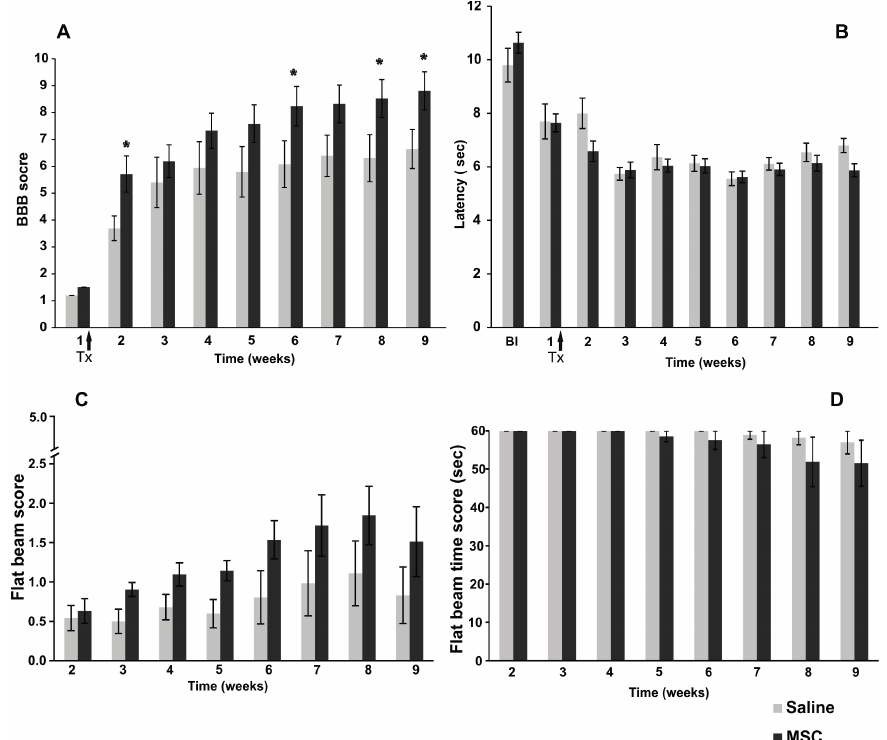
Figure 2. Functional recovery after spinal cord injury: ( A ) Improvement in locomotor behavior on the Basso, Beattie, and Bresnahan (BBB) scale after spinal cord injury (SCI) in control and MSC-treated groups. The MSC-transplanted rats demonstrated superior BBB scores with significant improvement, when compared to controls; ( B ) The plantar test was used to measure the effect of MSC implantation on thermal stimulation. No significant effect of implanted MSC on hyperalgesia was observed during the study; ( C ) The flat beam test evaluates the muscle strength, body and forelimb-hindlimb coordination in MSC and control groups. MSC-treated animals showed an insignificant strong trend improvement compared to the control group from the sixth week onwards after SCI; ( D ) The flat beam time score shows the ability of treated animals to move across the beam within 60 s, which was observed from the fifth week onwards in the MSC-treated group. Statistical significance is marked by * , where p ≤